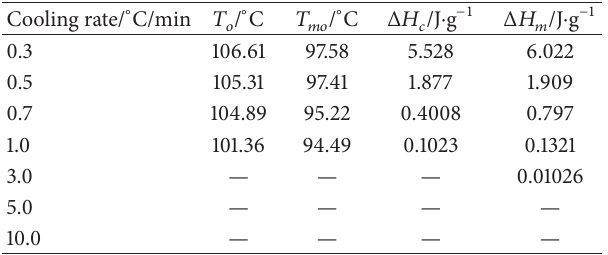
Table 1: DSC date of neat PLLA crystallized from the melt at different cooling